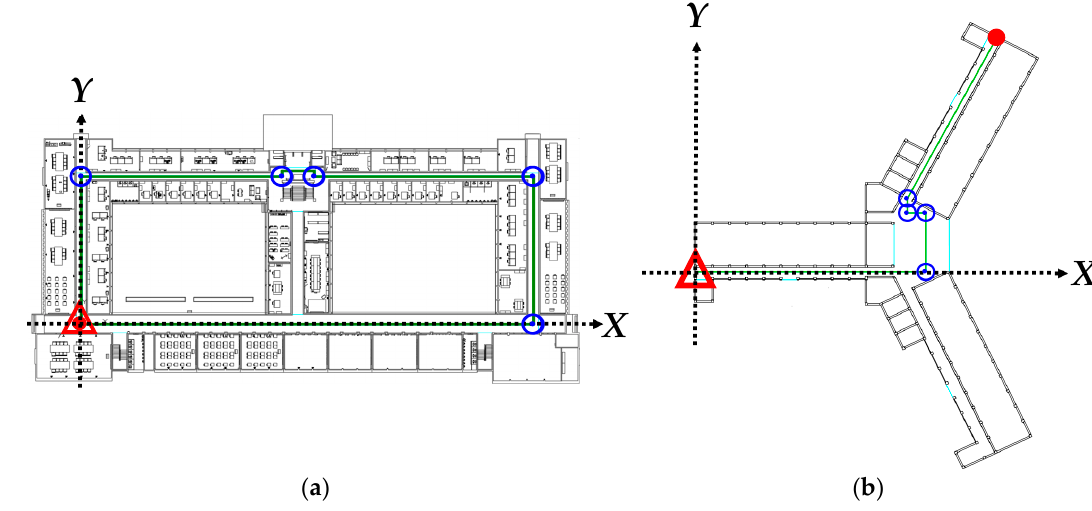
Figure 6. Paths and corner calibration points in the experimental fields: ( a ) Field 1; ( b ) Field 2. ( start point;